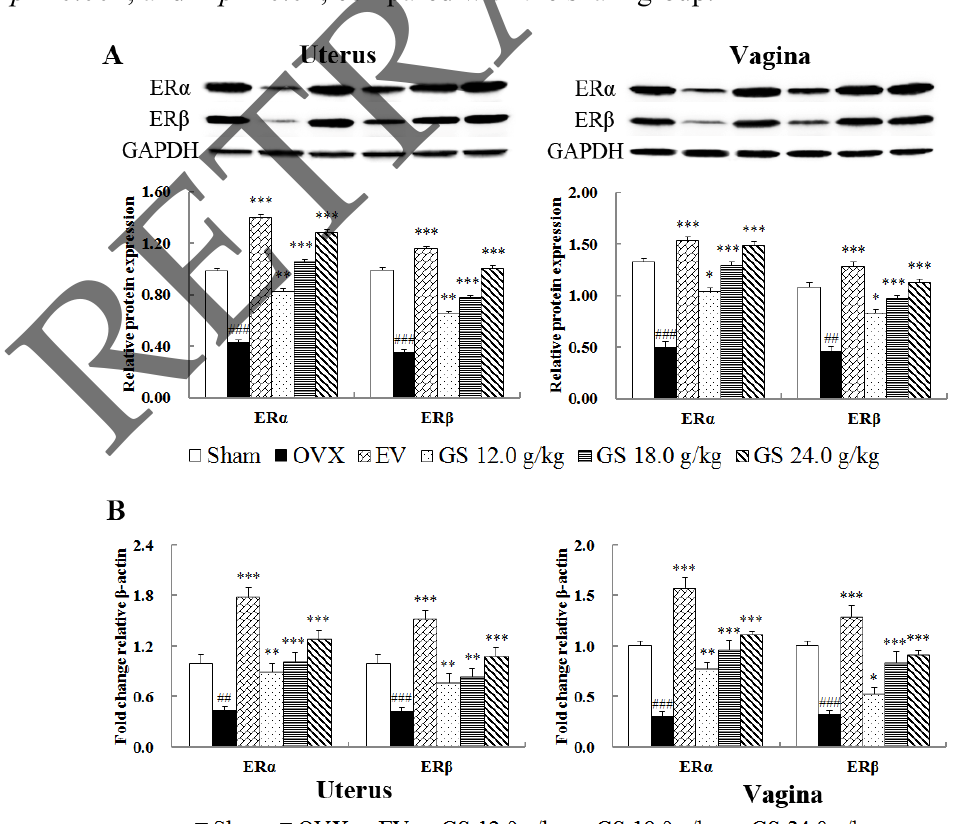
experiments. *** p < 0.001; ** p < 0.01; and * p < 0.05; compared with the OVX